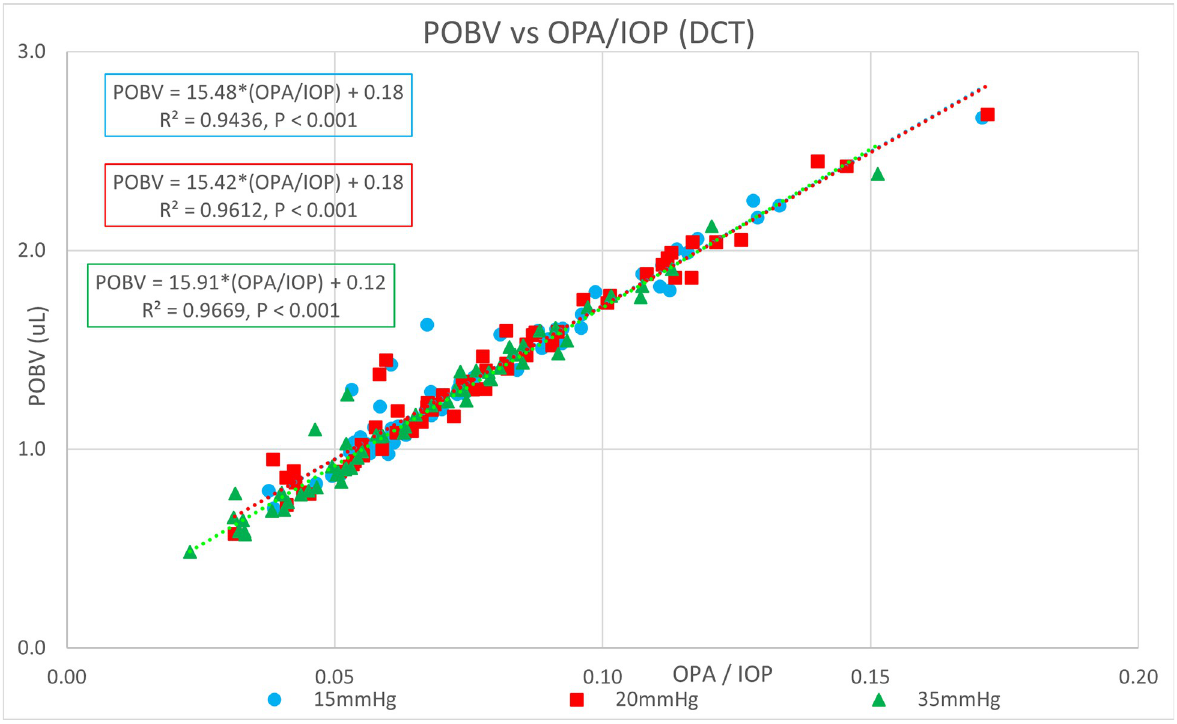
Fig 7. Strong correlation of the Calculated POBV to the Factor OPA/IOP for DCT Measurements.